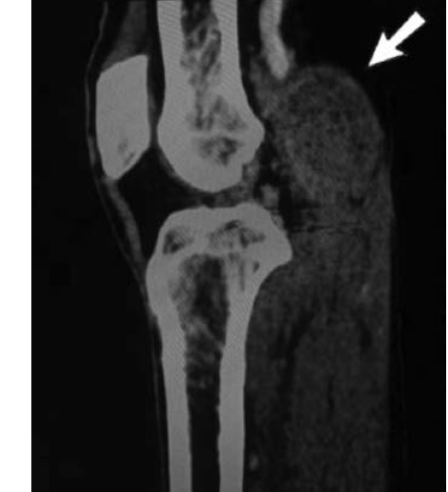
Contrast CT axial view showing a non-enhancing mass Fig. 2: (white arrow head) abutting onto a smaller calibre popliteal artery (black arrow).